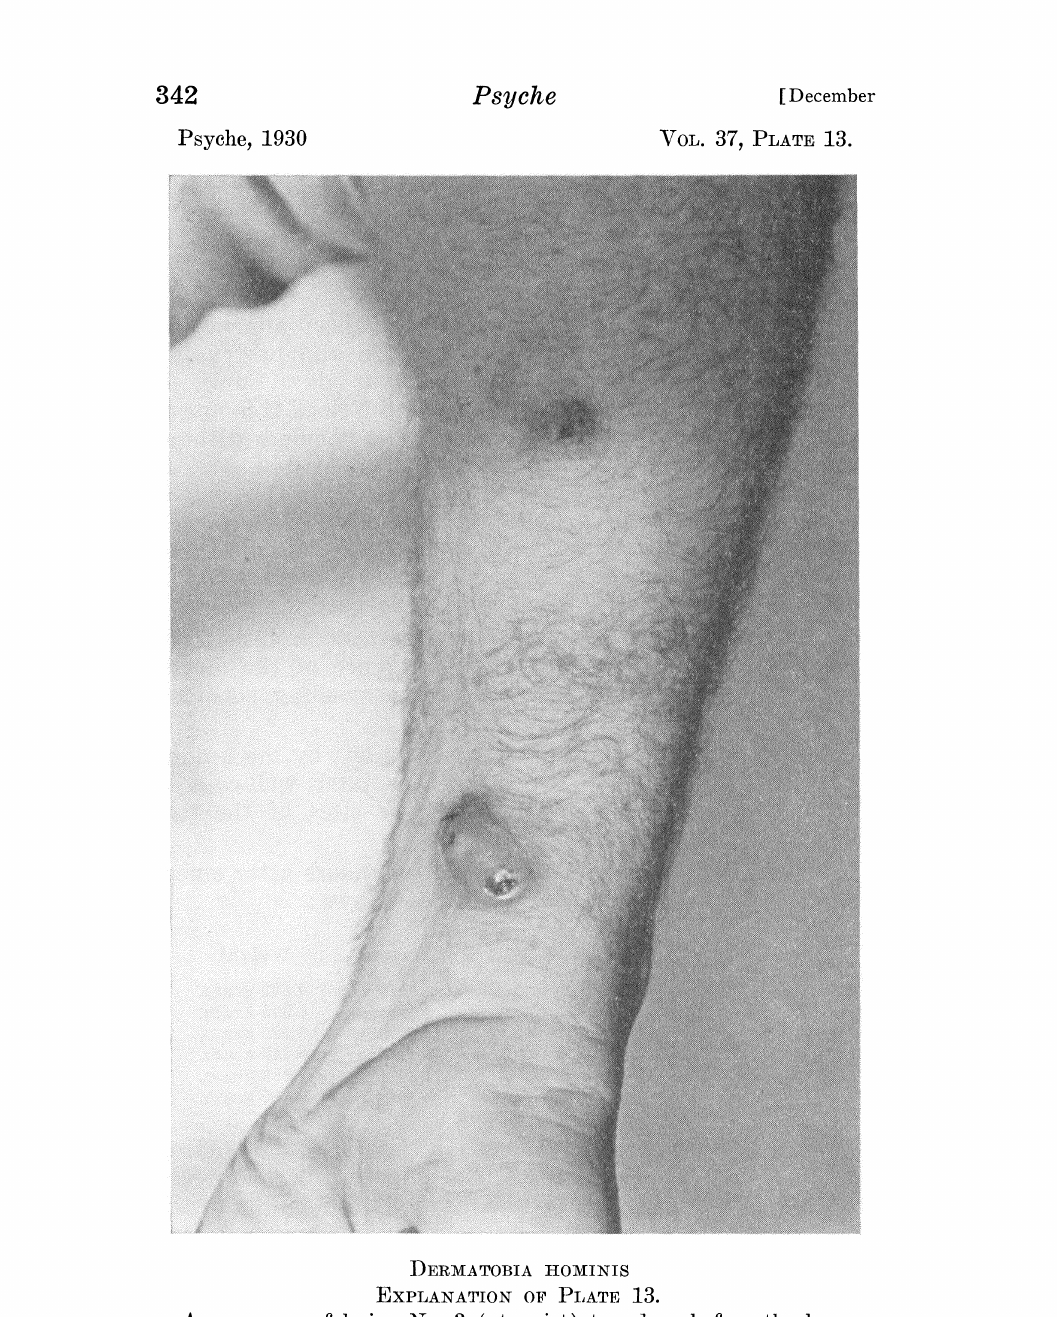
EXPLANATION OF PLATE